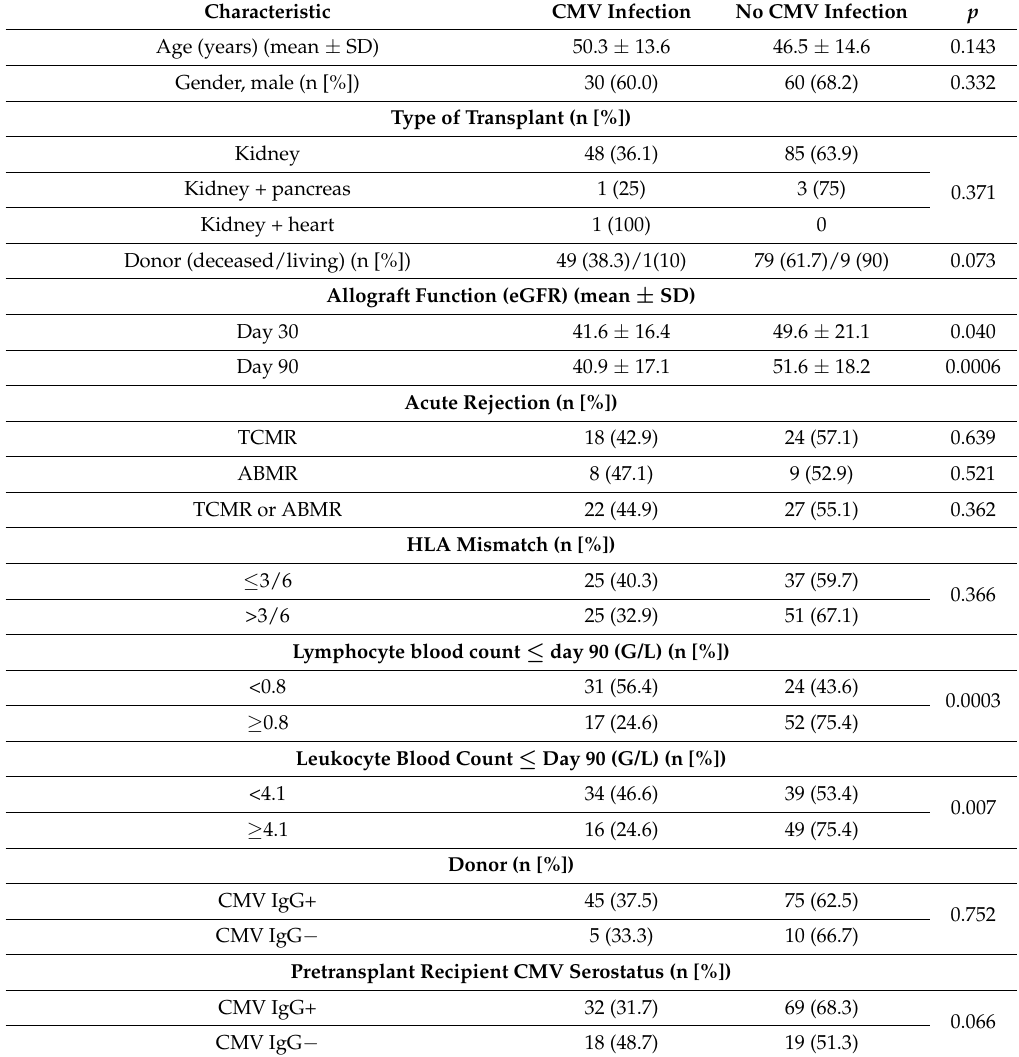
Table 4. Clinical characteristics of kidney transplant recipients stratified by the occurrence of CMV